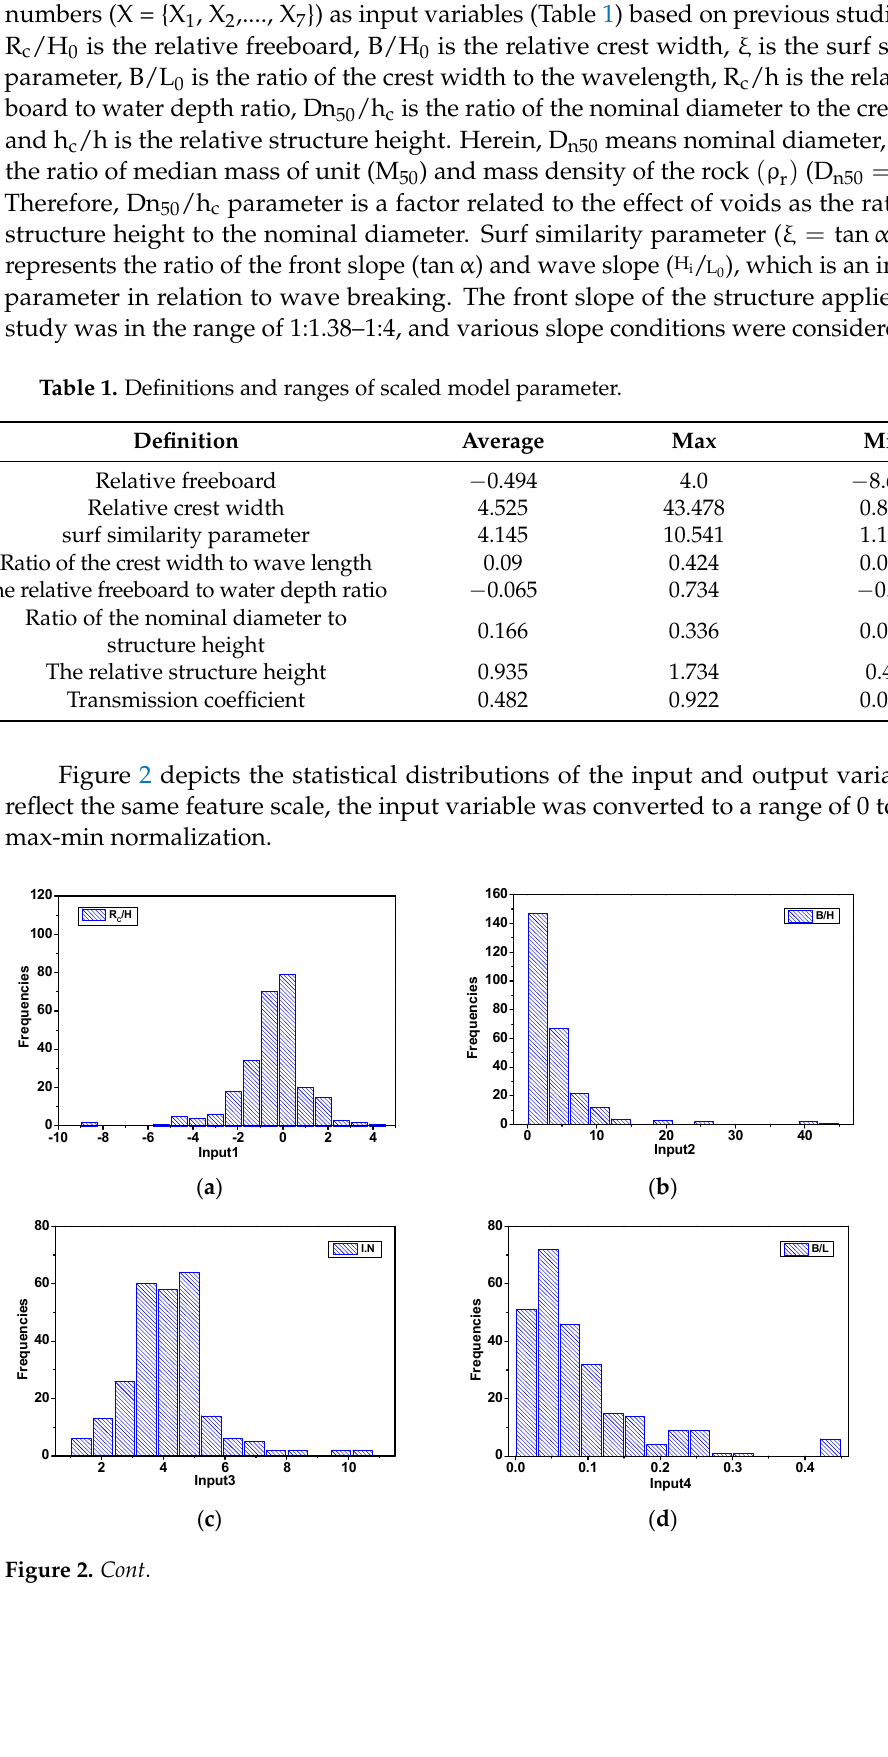
( h ) Figure 2. Results and discussion. ( a ): R C /H 0; ( b ): B/H 0; ( c ): ξ ; ( d ): B/L 0; ( e ): R C /h; ( f ): Dn 50 /h c ; ( g ): h c /h; ( h ): K t .